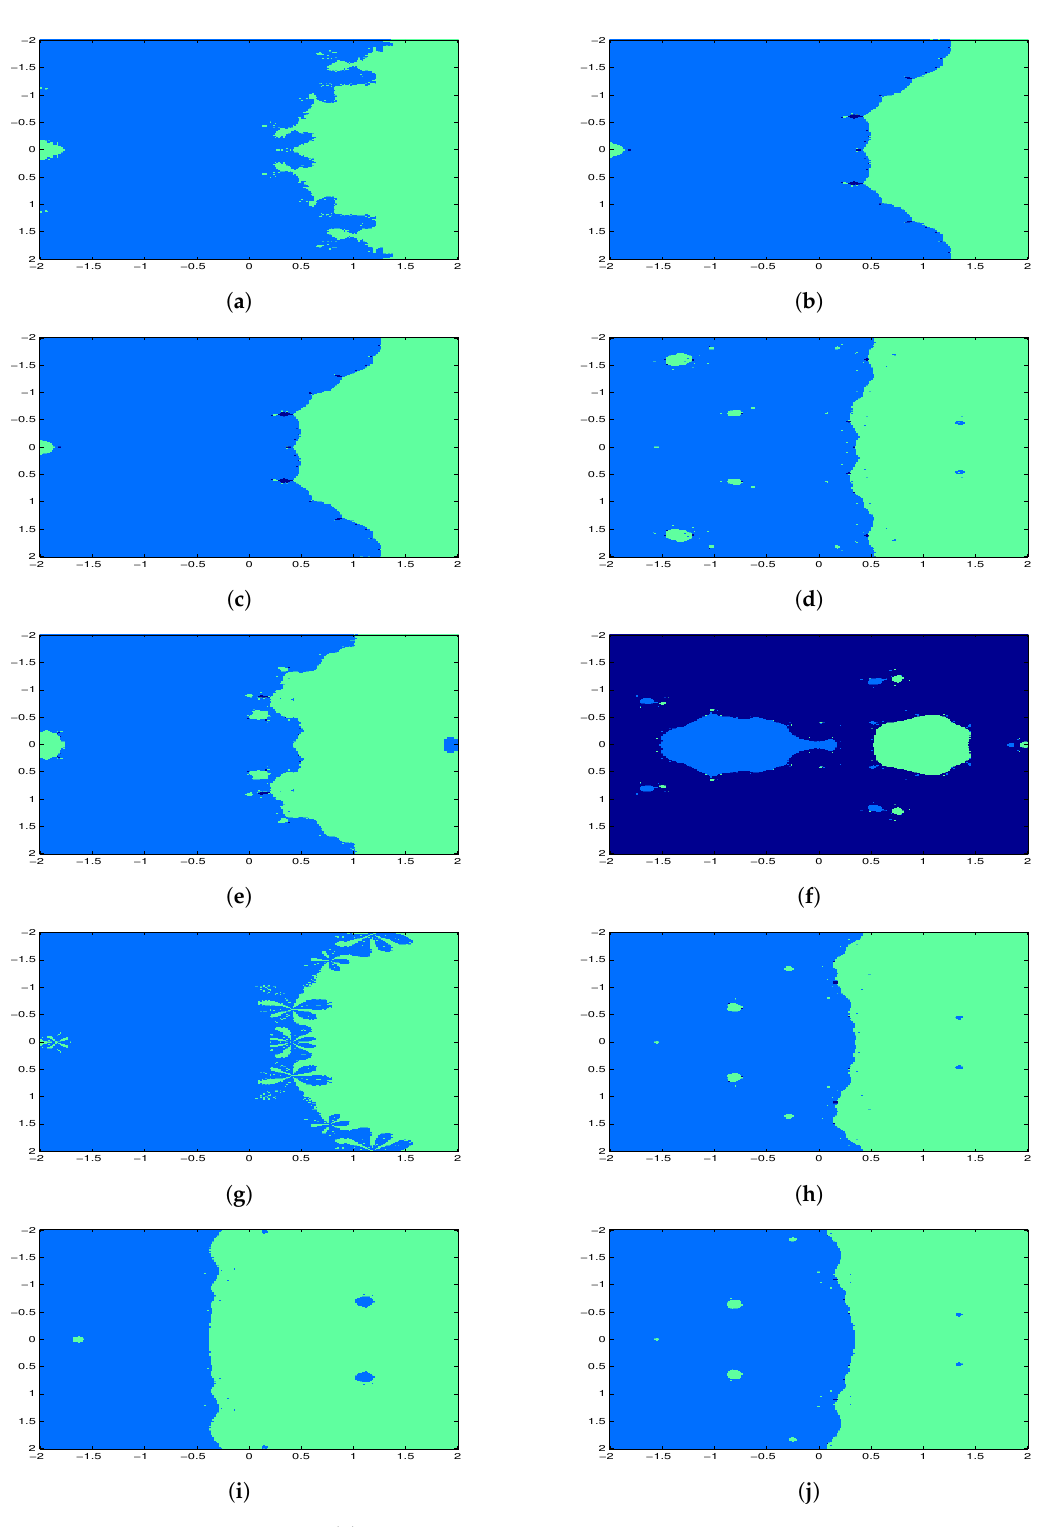
Figure 2. Polynomiographs of p 1 ( z ) : ( a ) KTM 4; ( b ) AKKB 4; ( c ) ZLM 4; ( d ) PM 4; ( e ) AKKB 8; ( f ) KBK 8; ( g ) SM 8; ( h ) PM 8; ( i ) ZLM 16; and ( j ) PM